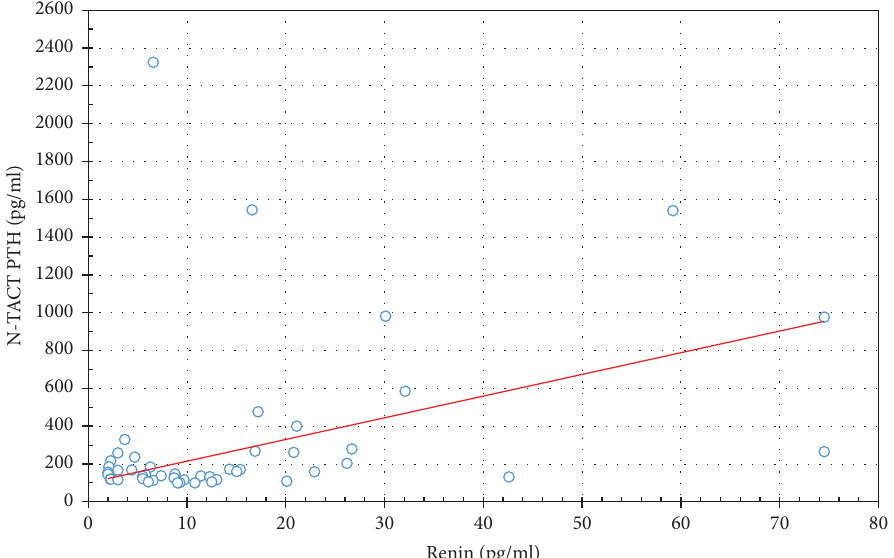
Figure 1: Correlation between PTH and renin in the study group ( r � 0.688, p <